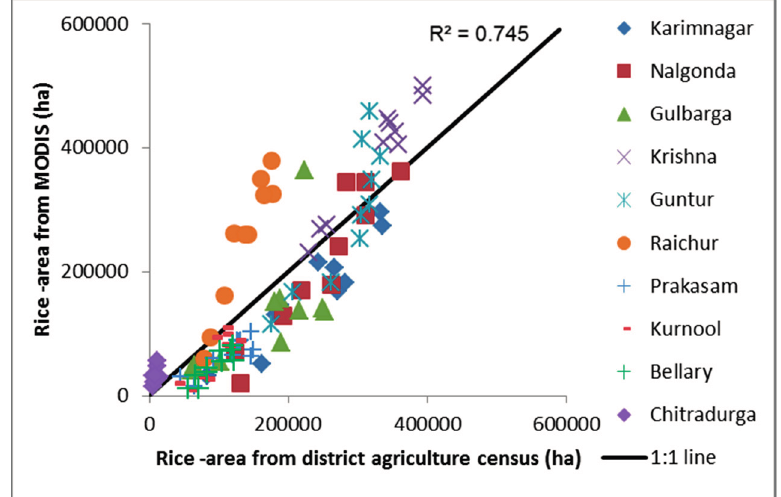
Figure 13. Correlations between rice areas derived using MODIS-500 m dataset and district wise agriculture statistics (each series represents one district from 2000–2001 to 2009–2010). Numbers of samples are 10 districts per year and number of years are 10. Areas shown on X- and Y-axes are in